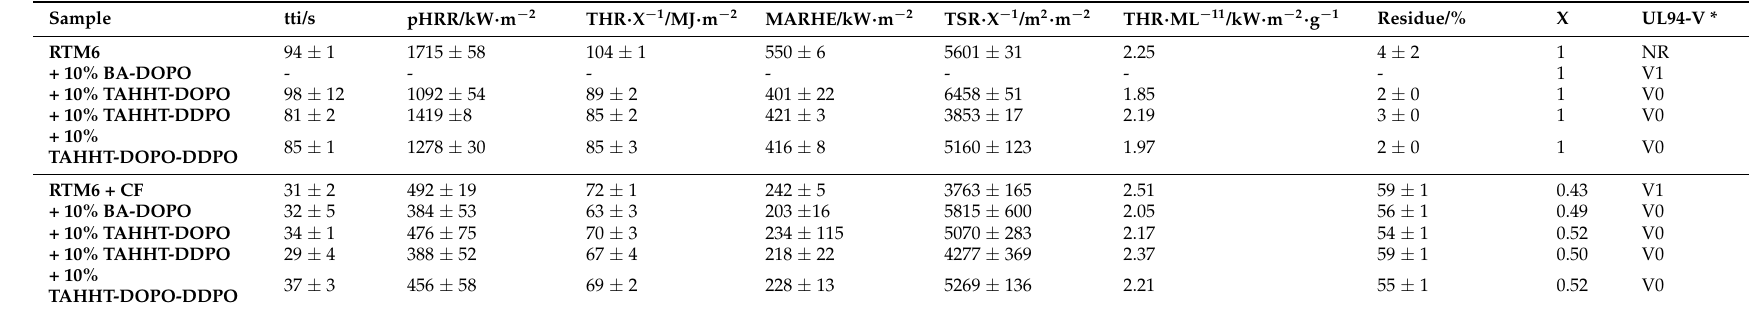
Table 6. Results of cone calorimetry (neat resin: sample thickness 4 mm, composites: sample thickness 2 mm) and UL94 (sample thickness 4 mm) for depicted